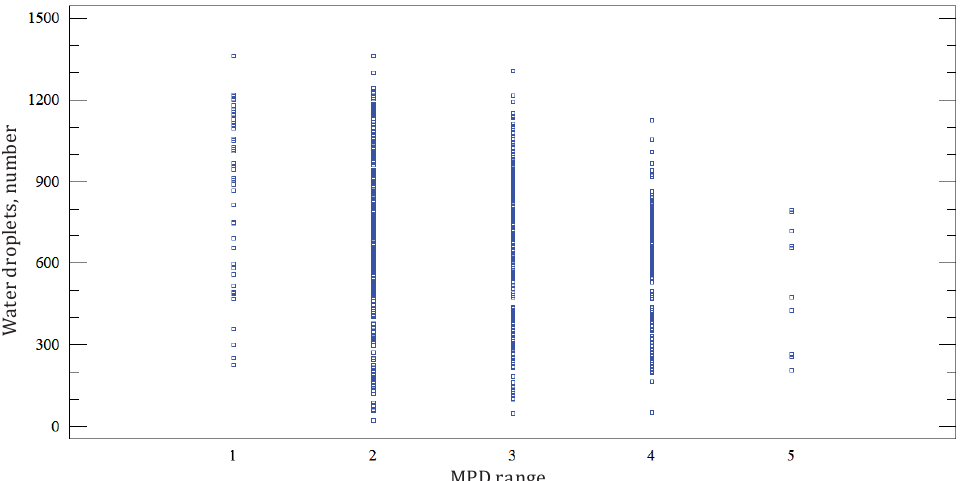
Figure 19. Scatterplot by level code. ANOVA analysis